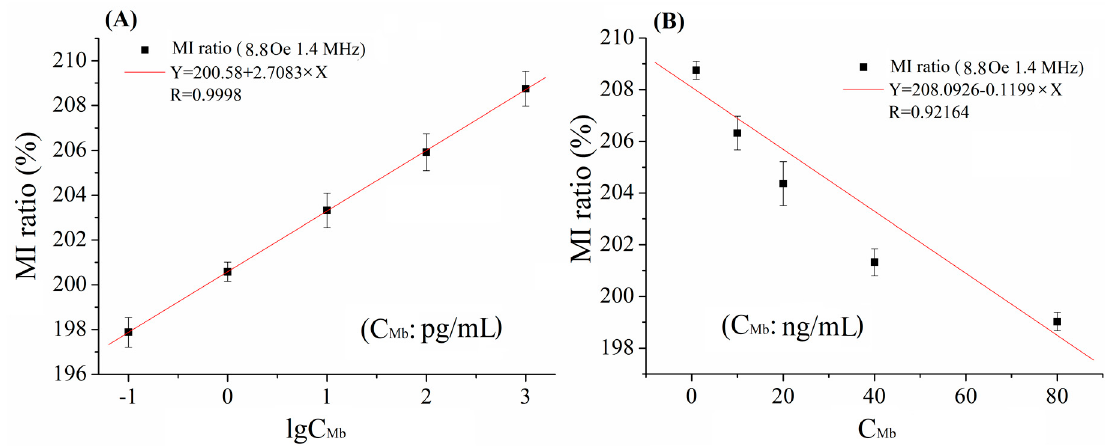
Figure 4. The relationship of MI ratio versus ( A ) low Mb concentrations and ( B ) high Mb concentrations at f = 1.4 MHz and H ex = 8.8 Oe.